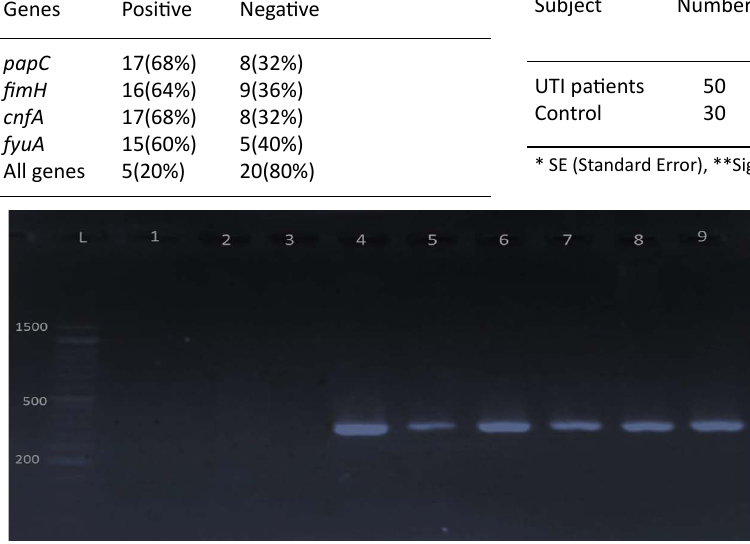
Fig. 2. Gel electrophoresis of PCR products of papC gene visualized under U. V light after mixed with ethidium bromide. L: 1500 bp DNA marker; lane 4-9 positive for papC gene and lane 1-3 negative results. The product size is 328 bp.